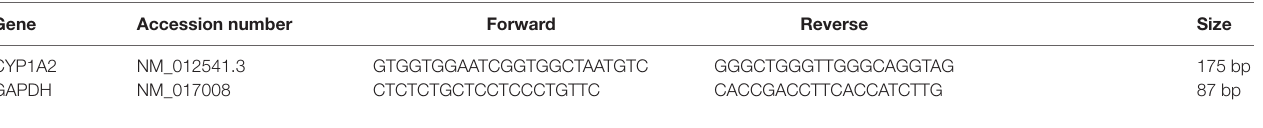
TABLE 1 | Gene specific primers used in